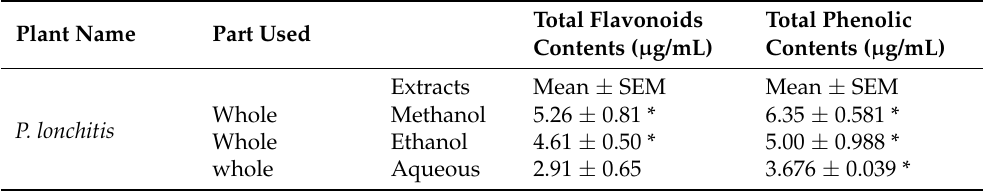
Table 6. Quantitative assessment of total flavonoids and phenolic contents. The mean difference was considered statistically significant at the 0.05 level. Significance indicated (* p <